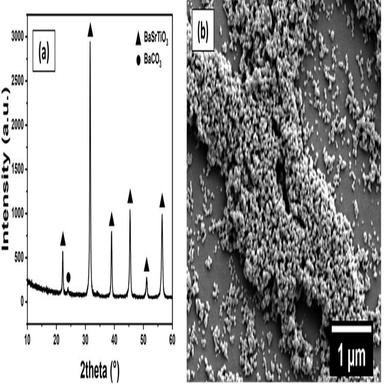
(a) X-Ray diffraction patterns, (b) SEM of the Barium Strontium Titanate powder.